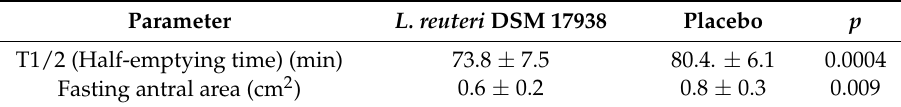
Table 4. Gastric emptying parameters at the end of the